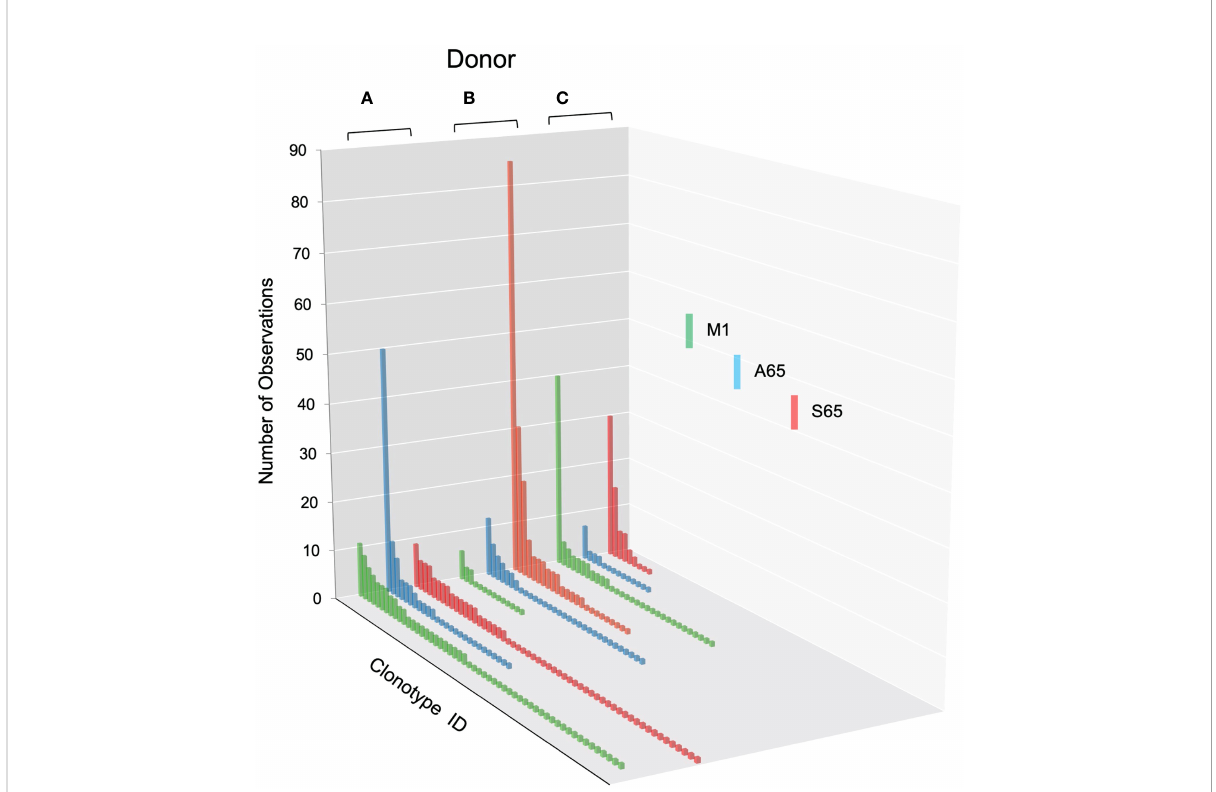
FIGURE 7 Clonotype distributions for non-cross-reactive clonotypes from M1, A65, and S65 peptide repertoires for all three donors. Donors A, B and C are identi fi ed above each clonotype distribution, and peptides are identi fi ed by color as shown in the legend. Clonotype frequencies are plotted in descending order and shown on the y-axis. Clonotype IDs for each donor are on the z-axis and omitted for simplicity. The repertoire characteristic values are provided in Table